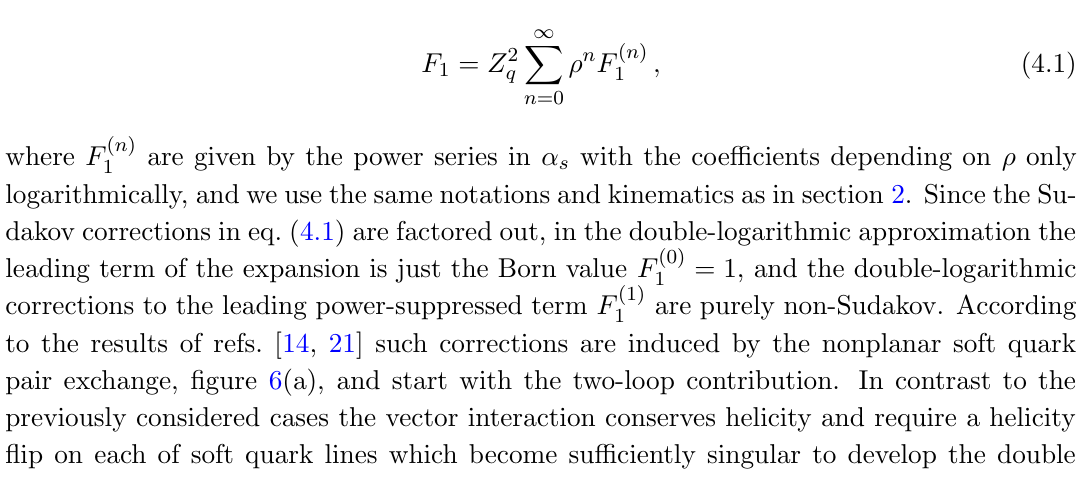
Figure 6 . The leading order two-loop Feynman diagrams for (a) vector form factor F (1) scalar form factor F (1) in the double-logarithmic approximation. The diagrams with an e(cid:11)ective S soft gluon exchange which incorporate the non-Sudakov double-logarithmic corrections to (b) vector and (d,e) scalar form factor. Symmetric diagrams and the diagrams with the opposite direction of the closed quark line are not